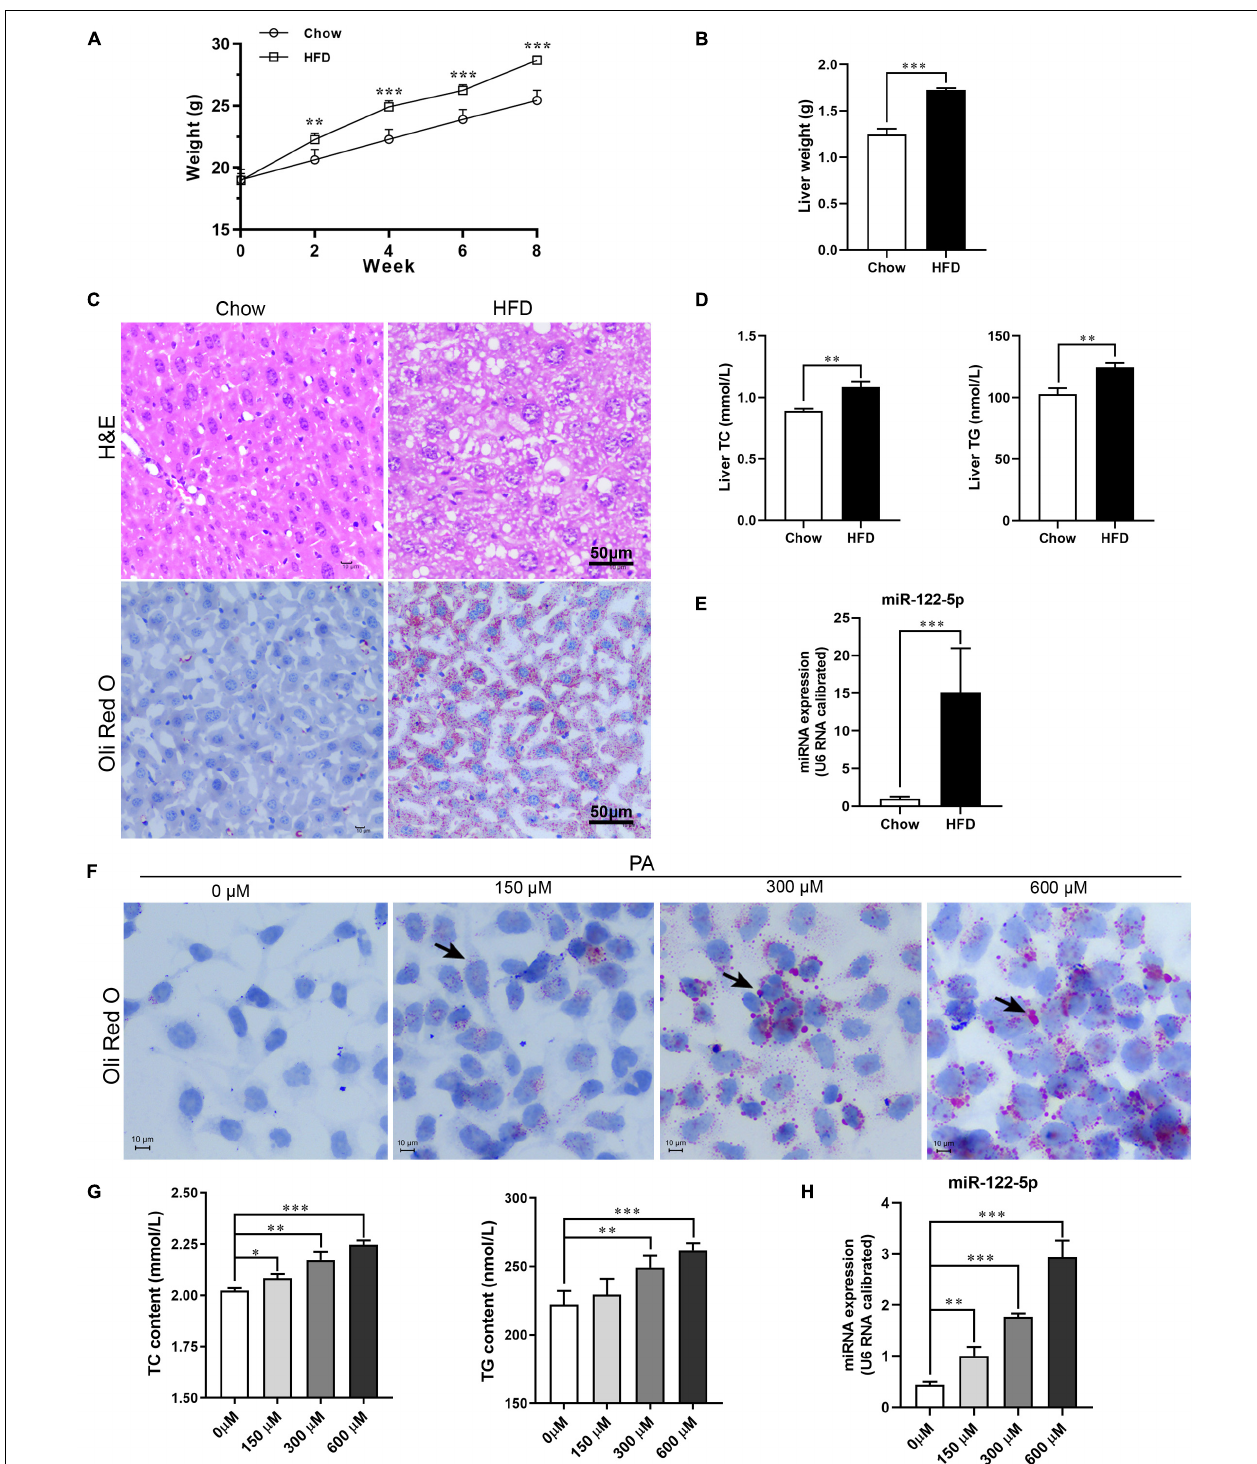
FIGURE 1 | High-fat diet (HFD) or palmitic acid (PA) promotes lipid accumulation and miR-122-5p expression in vivo and in vitro . (A) Monitor body weight of chow-fed and HFD-fed mice. (B) Liver weight. (C) Liver morphological characteristics were observed by H&E and Oli Red O staining of HFD-fed mice and chow-fed mice. (D) Hepatic total cholesterol (TC) and triglyceride (TG). (E) The expression level of miR-122-5p in liver. (F) Representative photomicrographs of PA (0, 150, 300, and 600 µ m)-induced lipid accumulation by Oil Red O staining. (G) The contents of intracellular TC and TG after treated with PA. (H) The miR-122-5p expression in L02 after treated with PA. Error bars indicate SD. ∗ P < 0.05, ∗∗ P < 0.01, ∗∗∗ P < 0.001.